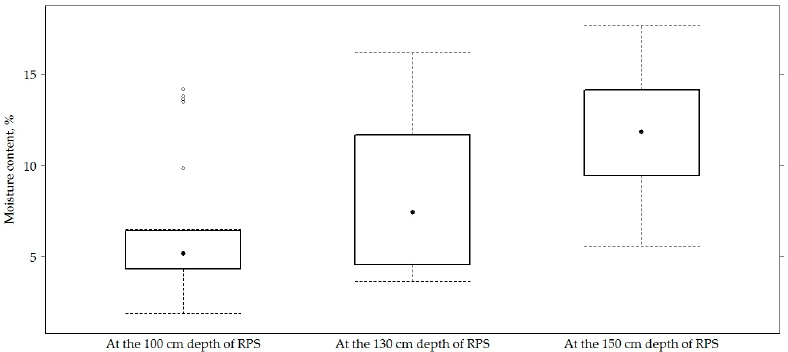
Figure 7. The box-plot of moisture content of the soils in the subgrade.